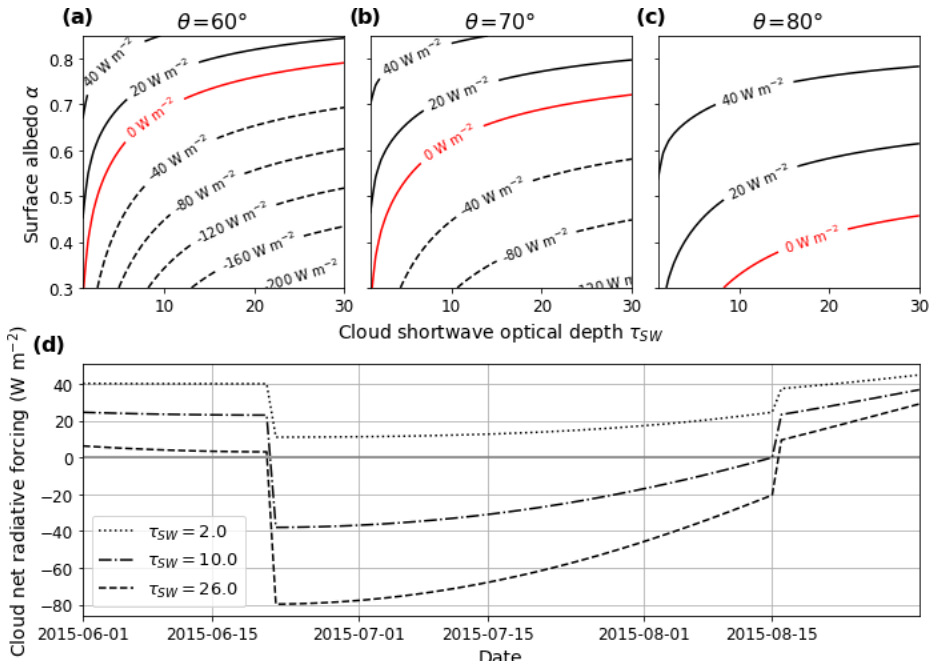
Figure 7. (a–c) Iso-contours of net surface radiative forcing as a function of albedo and cloud shortwave optical depth for three different solar zenith angles (Eq. 8). Dashed black lines correspond to negative iso-contours, solid black lines to positive iso-contours and red lines to the 0Wm − 2 iso-contour. (d) Calculated evolution of the net surface cloud radiative forcing, for three different CODs (dotted line: τ SW = 2; dash-dotted line: τ SW = 10; dashed line: τ SW = 26), over the 2015 summer period. The summer variation of the albedo is constructed based on values from the NCAR Climate System Model (Weatherly et al., 1998), and the solar zenith angle values are daily averages at 82 ◦ N, 14 ◦ W (approximate position of the N-ICE ice